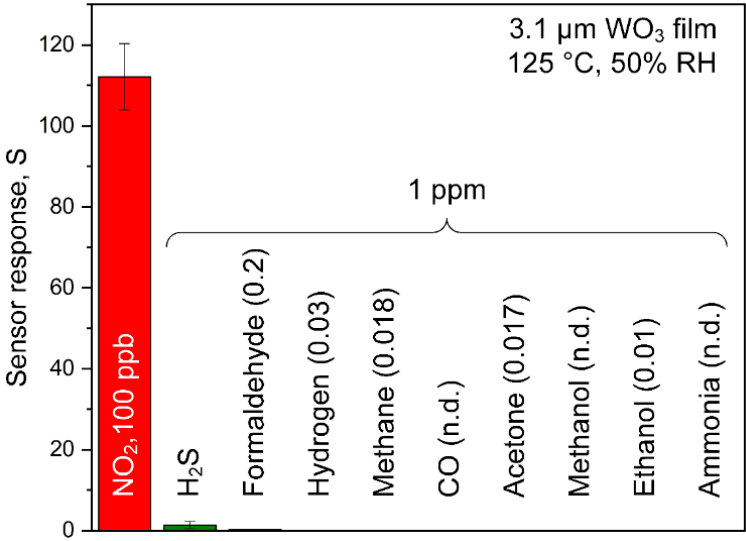
Figure 6. Selectivity. Sensor responses of the thickness-optimized 3.1 µ m WO 3 film to 100 ppb of NO 2 and 1 ppm H 2 S, formaldehyde, hydrogen, methanol, CO, acetone, methanol, ethanol, and ammonia at 50% RH (at 23 °C). Please note that no response was detectable for CO, methanol, and ammonia.